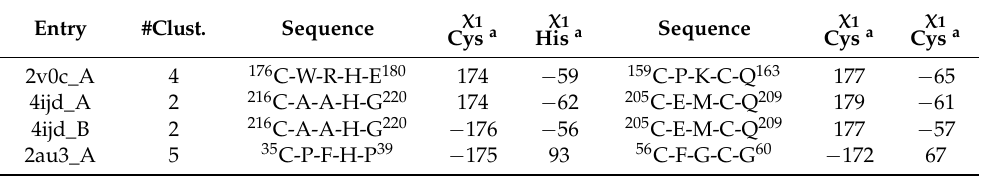
Table 5. Pseudo-symmetric Cys 3 His dimers observed in the database.